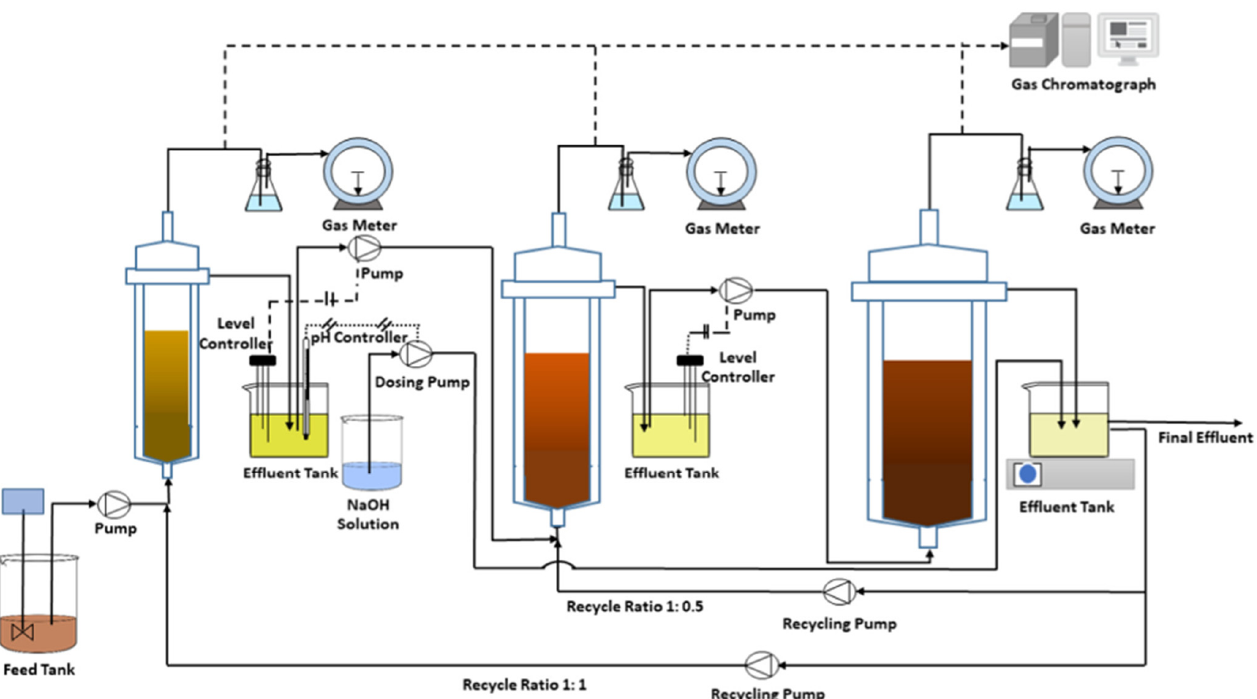
Figure 6. Three-stage UASB reactor [47] .